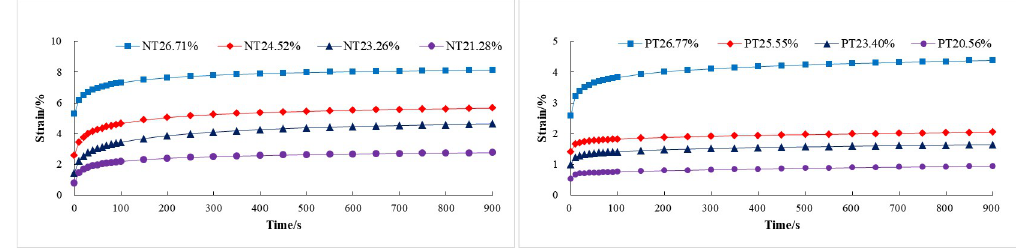
Fig 4. Creep properties curve of paddy soil under different moisture content. (a) No tillage; (b) Plough tillage.